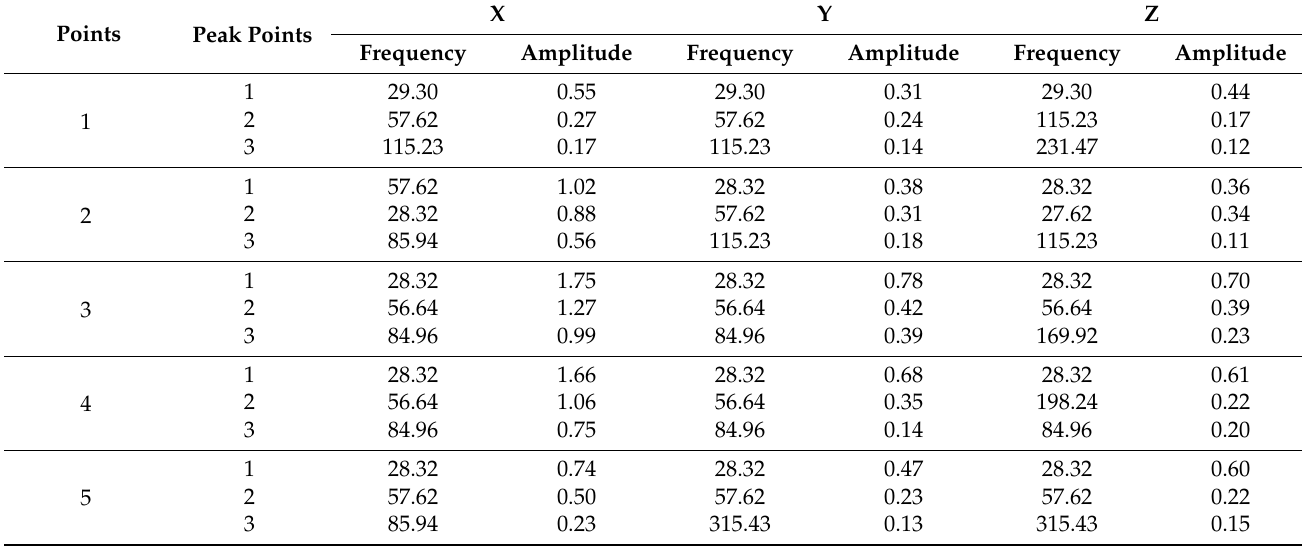
Table 5. Frequency data of measuring points in idle condition.